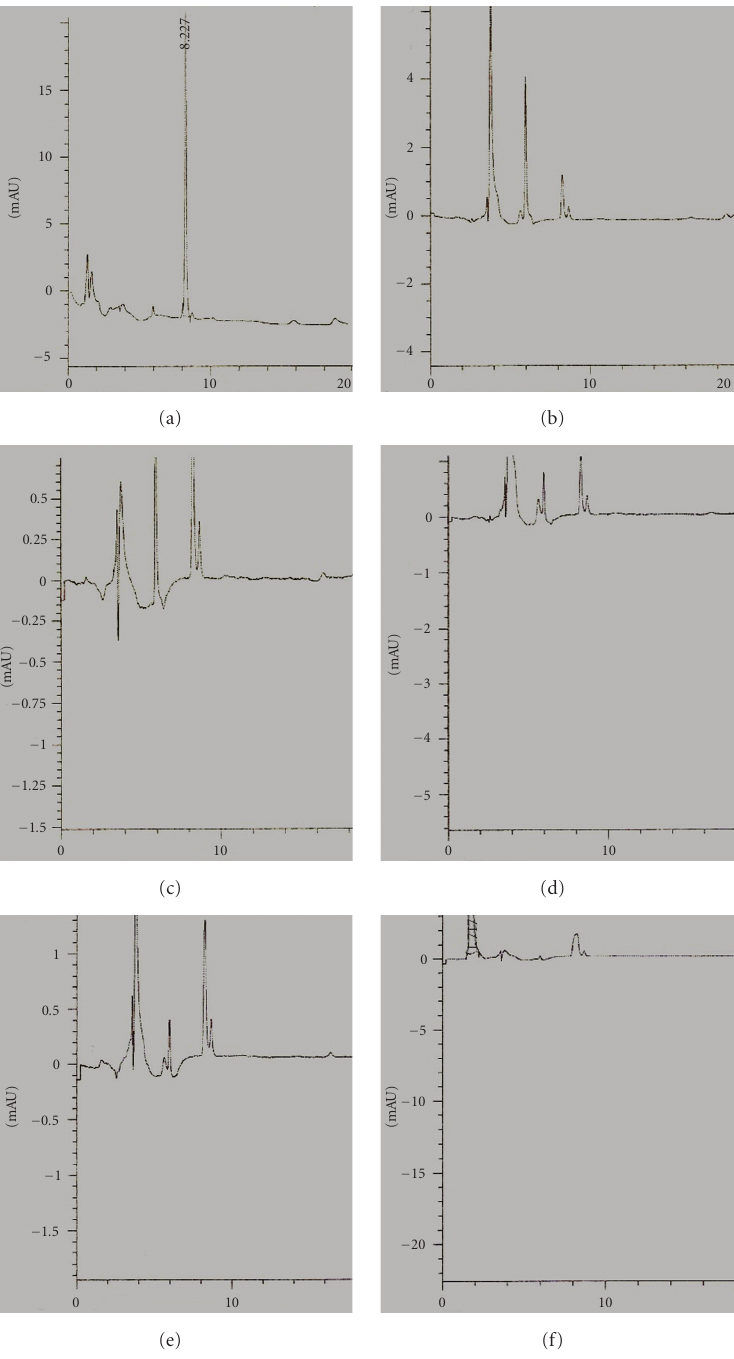
Figure 4: BHT spectra: (a) standard (10mg/ml); (b) Seedlings extract; (c) Juvenile extract; (d) Adult extract; (e) Floraison extract by Method 1; (f) Floraison extract by Method